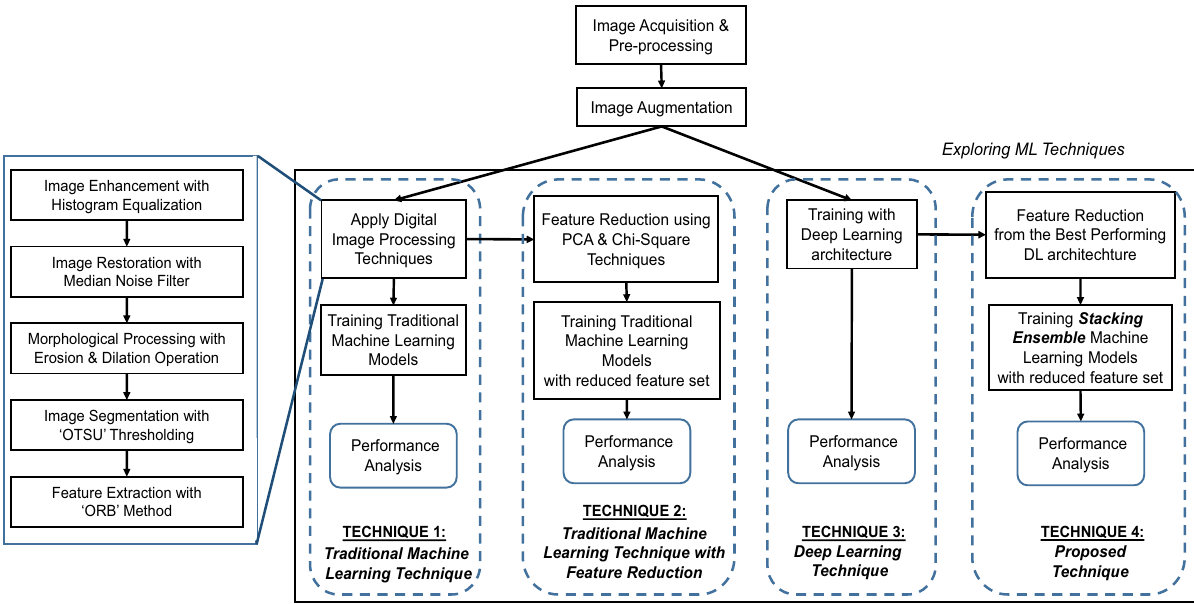
Figure 1. Framework of research